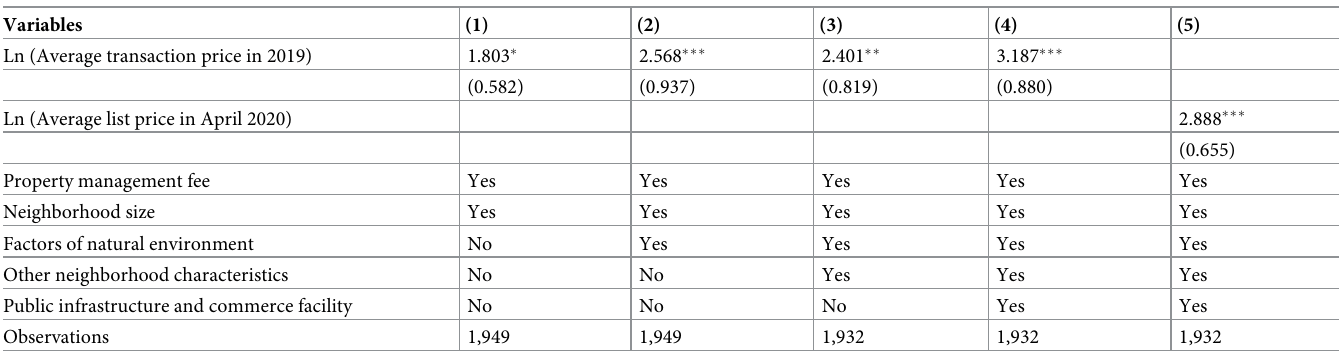
Table 4. Robustness tests.